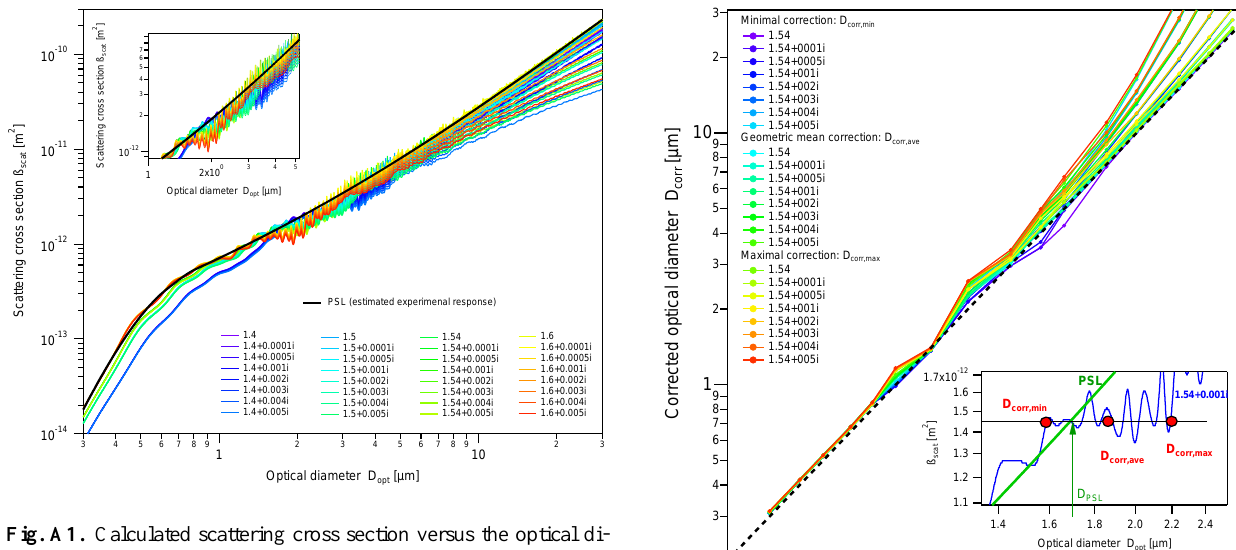
Fig. A1. Calculated scattering cross section versus the optical di- ameter for different refractive indices (see legend), considering the technical details of the used OPC (see text for details).